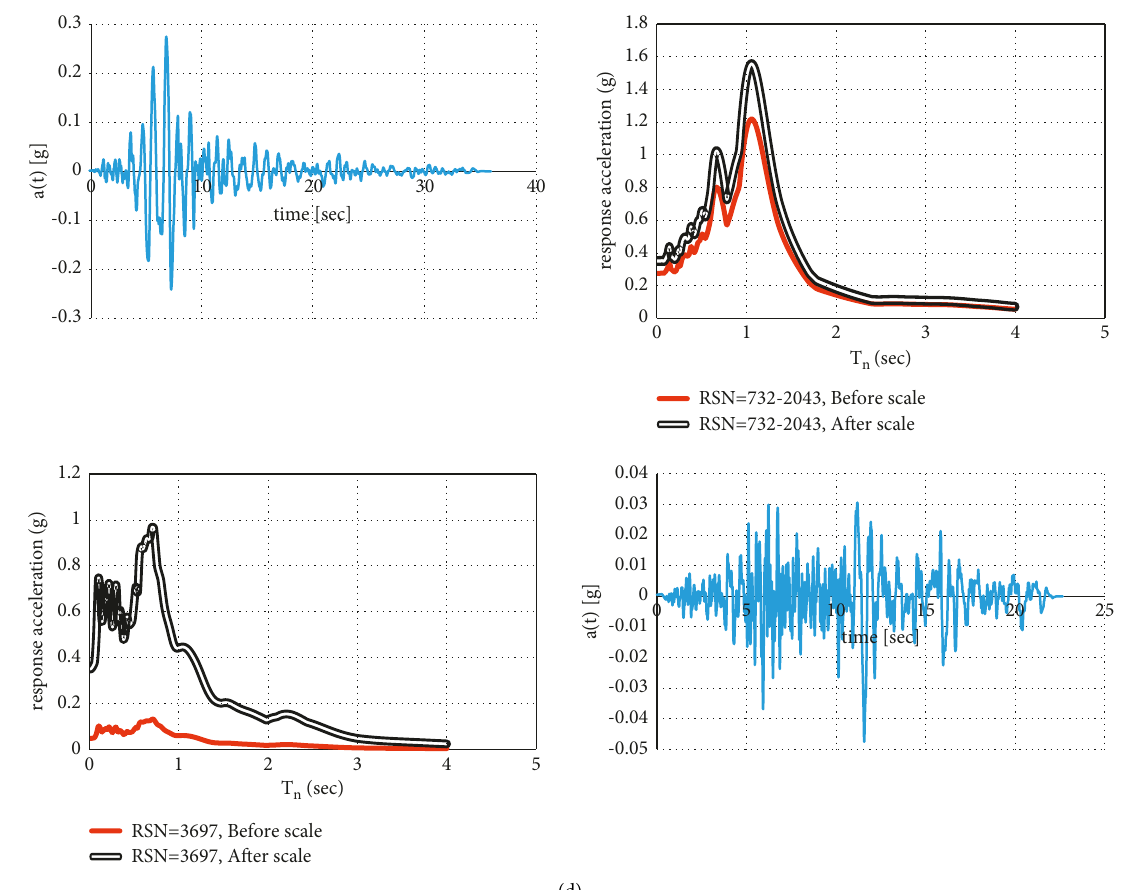
Figure 2: Acceleration records used in the study and comparison of their response spectrum before and after scaling PGA to 0.35